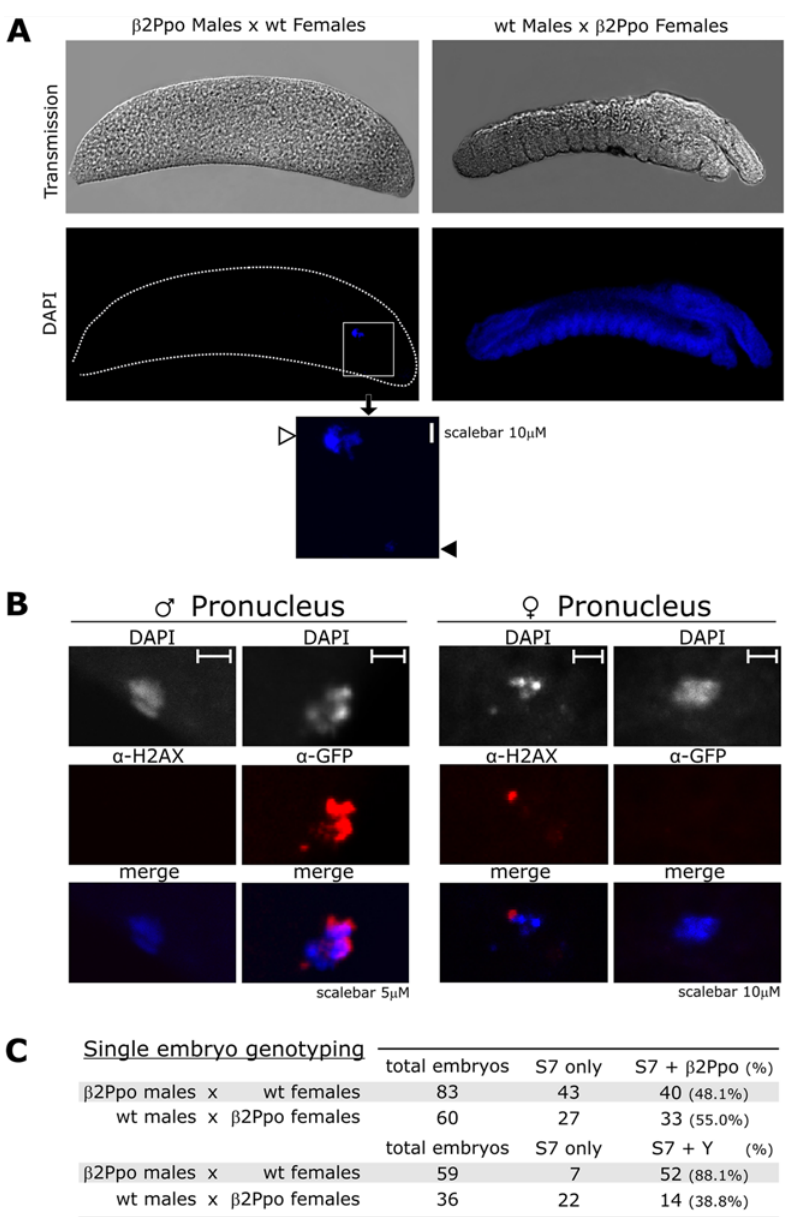
Figure 3. Morphological and genotype analysis of developmentally arrested embryos. (A) Embryos originating from crosses between b 2Ppo males with WT females (left) compared to crosses between WT males and b 2Ppo females (right) were analyzed by fluorescence microscopy 24 hours after oviposititon. The figure shows transmission (upper panels) and fluorescence of DAPI staining DNA (lower panels) of embryos oriented with the posterior end to the left and ventral side up. The inset shows a magnified view of the small and large DAPI stained bodies found in the embryos marked with a black and a white arrow respectively. (B) Immunostaining of freshly hatched embryos using mouse anti GFP ( a -GFP) or mouse anti c -H2AX ( a -H2AX) primary in combination with anti-mouse IgG Alexa-532 conjugated secondary antibodies. DAPI stained bodies identified as male pronucleus and female pronucleus are shown at 5 and 10 m M scale respectively. (C) Molecular genotyping of embryos using multiplex PCR. Embryos originating from crosses of b 2Ppo males with WT females and WT males with b 2Ppo females were collected at 24 hrs post deposition and their DNA was examined using nested PCR analysis to amplify Y chromosome or transgene specific sequences as well as the ribosomal gene S7 as a control. The values show the frequency of the genotypes in all embryos that tested positive for the presence of